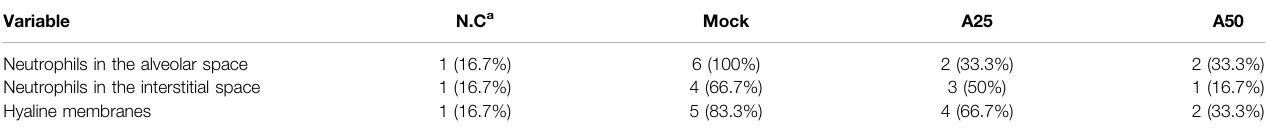
TABLE 1 | Histopathological scoring of the therapeutic effect of aspirin on hyperoxia-induced acute lung injury in lung tissues ( n (cid:1) 6) of NF- κ B-luciferase +/+ transgenic mice. Variable N.C a Neutrophils in the alveolar